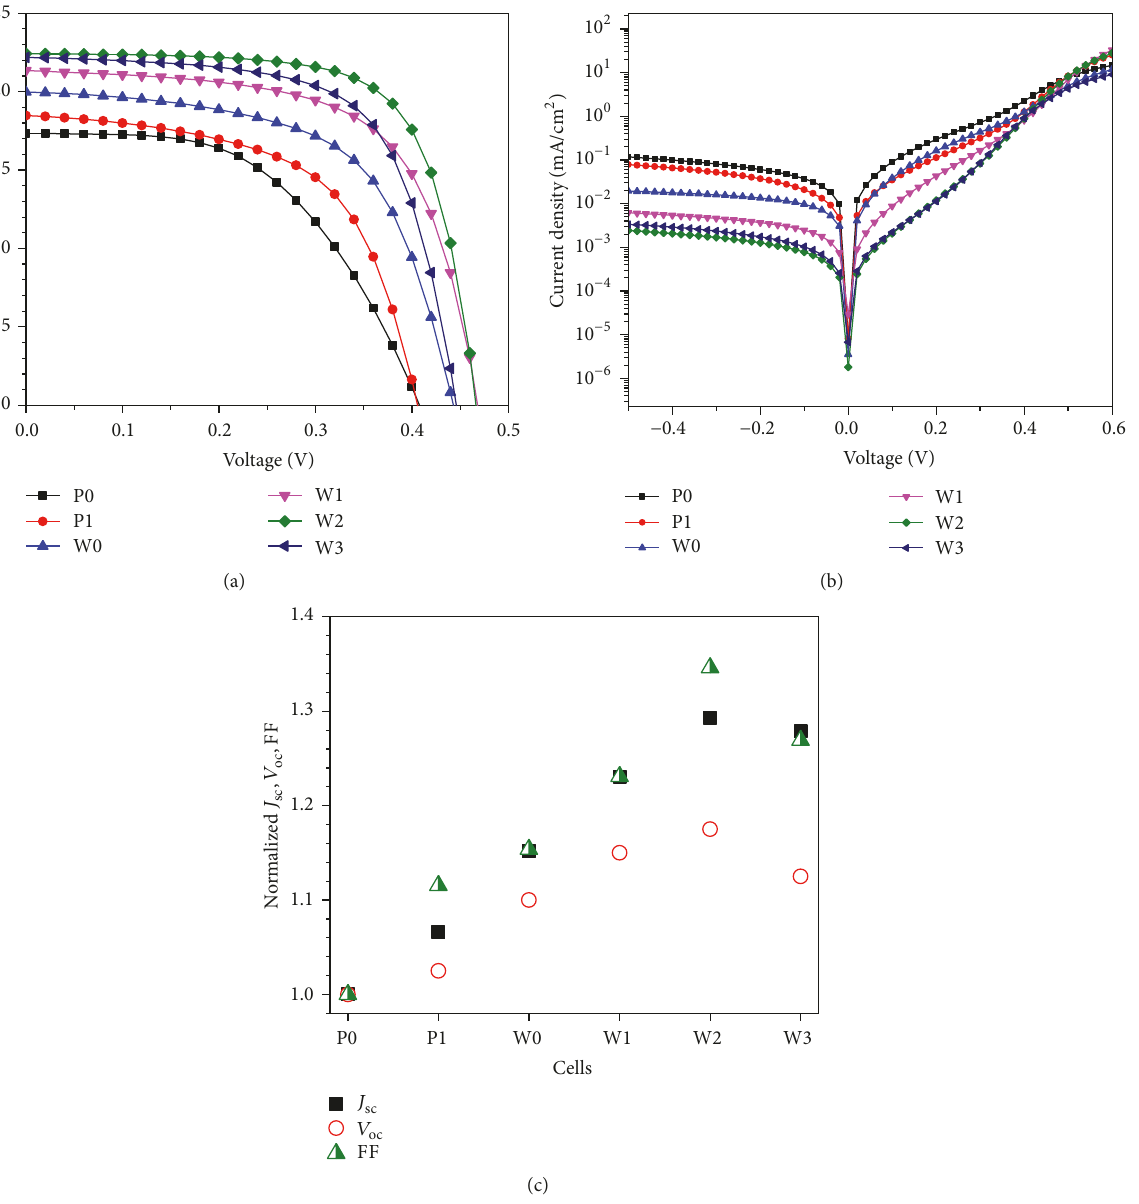
Figure6: J - V characteristic(a)under100 mW/cm 2 illuminationwithanAM1.5 Gsolarsimulatorand(b)indarkand(c)solarcellparameters normalized with respect to a cell P0 of hybrid solar planar based cells and